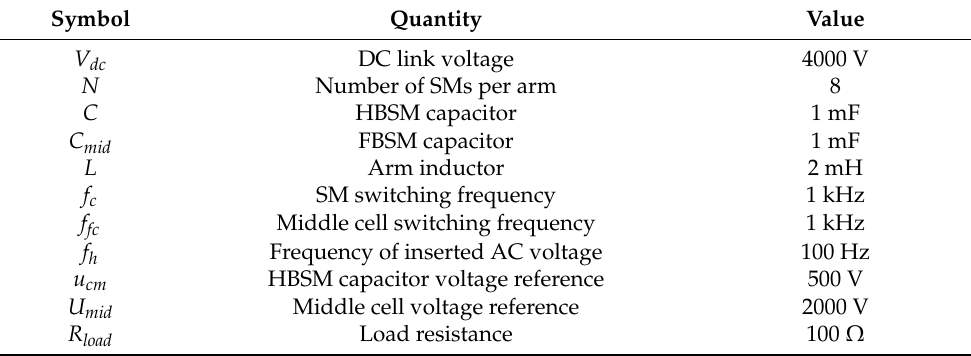
Table 3. Circuit parameters for